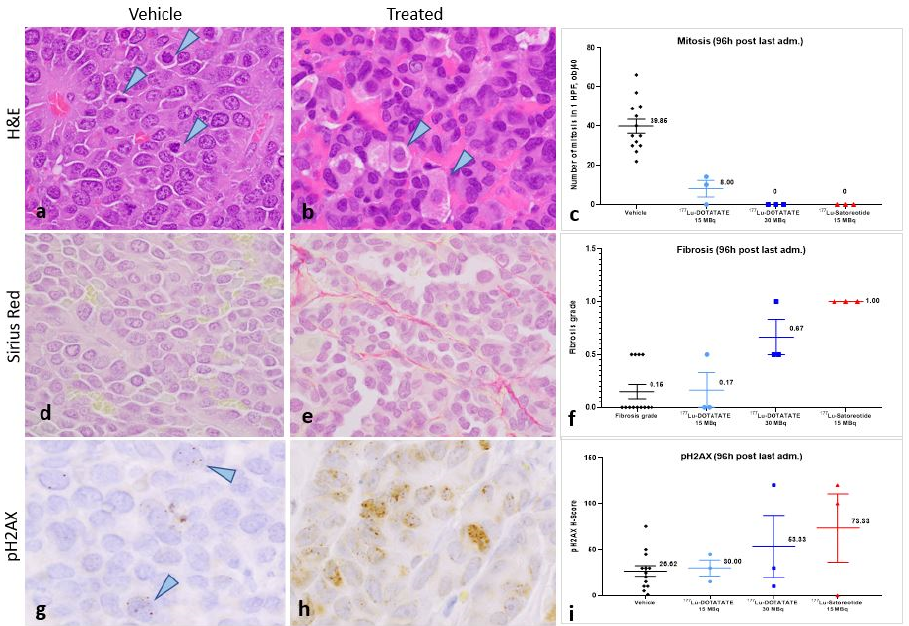
Figure 4. Histopathological and immunohistochemical analyses at 96 h post-administration of last treatment. ( a , b ) are representative images of haematoxylin and eosin (H&E) tumour staining. ( a ) The arrowheads point to mitoses in a control/untreated tumour. ( b ) In a [ 177 Lu]Lu-satoreotide tetraxetan-treated tumour, mitoses were absent. The arrowheads point to degenerating cells. ( c ) Mean ± standard error of the mean (SEM) mitotic count (ranging from 22 to 66 at objective 40 in control tumours). ( d , e ) are representative images of sirius red staining. ( d ) In a control/untreated tumour, fibrosis was absent. ( e ) Fibrosis grade 1 (minimal) was noted in a [ 177 Lu]Lu-satoreotide tetraxetan-treated tumour. ( f ) Mean ± SEM fibrosis score, ranging from 0 to 4. ( g , h ) are representative images of pH2AX tumour staining. ( g ) In a control/untreated tumour, there were low levels of staining in the nuclei of cancer cells (arrowheads) unlike in a [ 177 Lu]Lu-satoreotide tetraxetan-treated tumour ( h ). ( i ) Mean ± SEM pH2AX H-score, ranging from 0 to 300. Figure ( a , b , d , e ) were taken at the objective 40, and figures ( g , h ) at the objective 100.